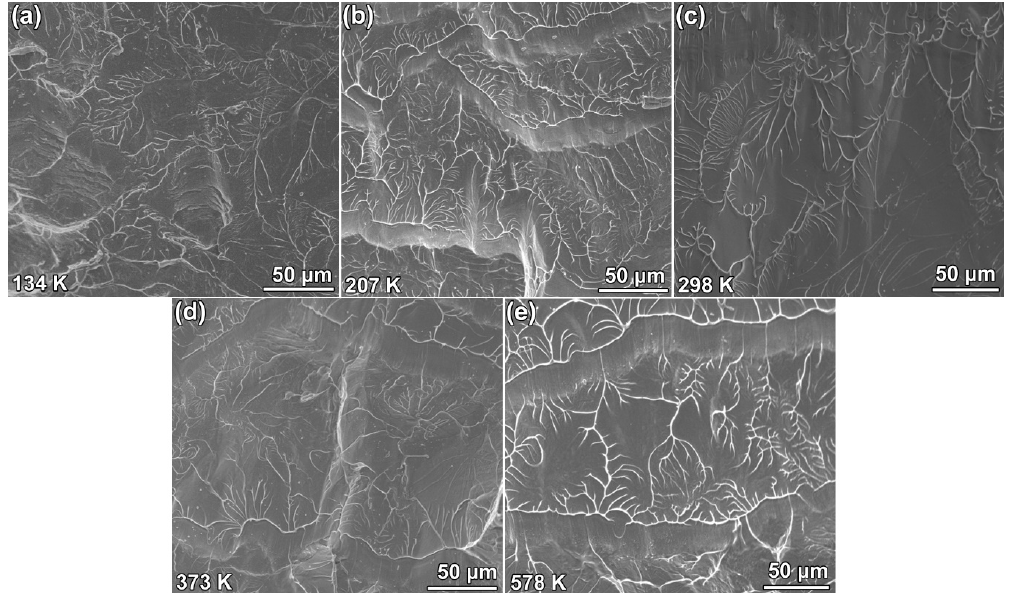
Figure 4. Pattern on the fracture surface of specimens tested at 134 ( a ), 207 ( b ), 298 ( c ), 373 ( d ), and 578 K ( e ).